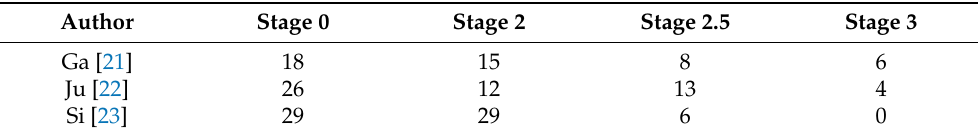
Table 2. Number of subjects in three sub-datasets of Parkinson’s Disease database (gaitpdb) [8] based on the HY rating scale of